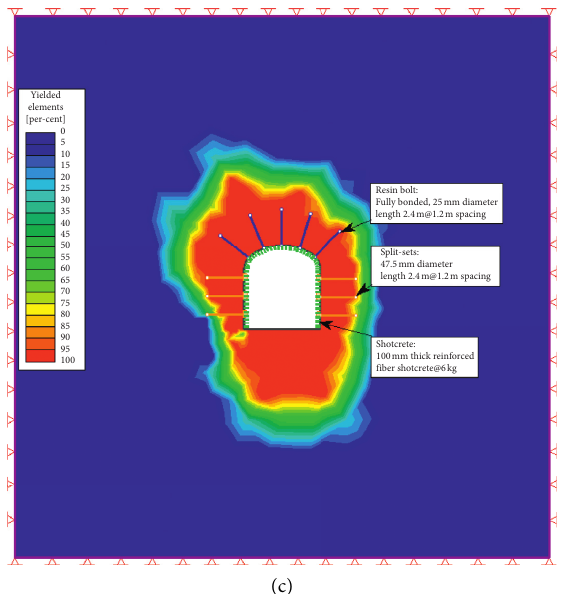
Figure 12: Simulation effect of the original support scheme. (a) The distribution of maximum principal stress. (b) The displacement of surrounding rock. (c) The distribution of rock mass